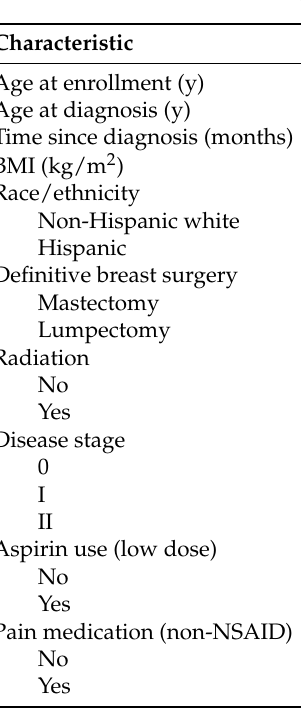
Table 1. Baseline characteristics ( n =